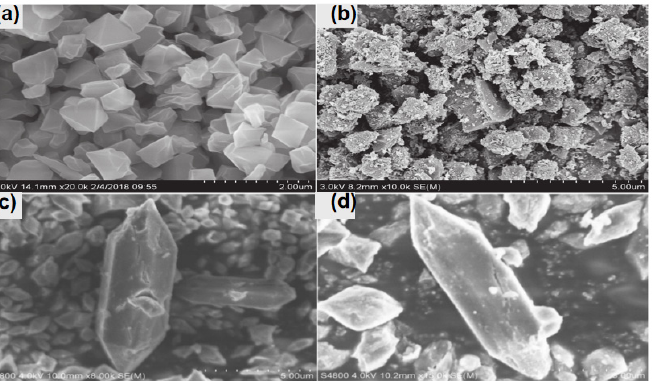
Figure 6. The SEM images of ( a ) MIL-101(Cr) [21], ( b ) nZVI/MIL-101(Cr) [21], ( c ) MIL-88B-Fe, and ( d ) CUCs-MIL-88B-Fe [50]. ( d ) CUCs-MIL-88B-Fe